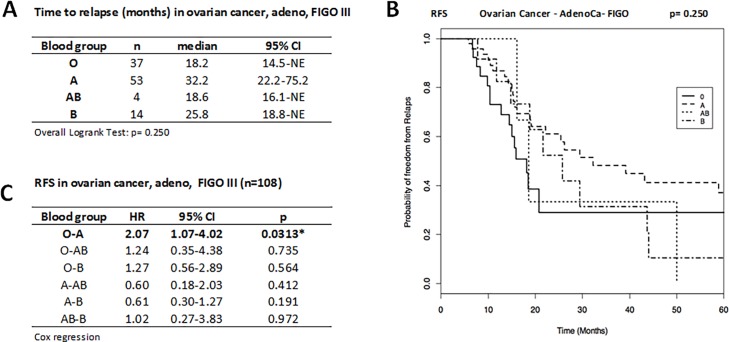
Time to relapse (A), Kaplan-Meier curve for RFS (B), and HR for disease recurrence (C) in the FIGO III adenocarcinoma patient subgroup (n = 108). BG O patients have two time increased risk for relapse compared to A patients A, i.e. BG A patients have better prognosis with a significant longer RFS than patients with O. Time to relapse presented as median (months) and 95%CI and compared by overall Logrank test. Disease recurrence risk presented as HR and 95%CI by Cox regression. Statistical significance marked by asterisks (*) or highlighted. NE, not estimable. RFS given as probability of freedom from relapse as a function of time (months).